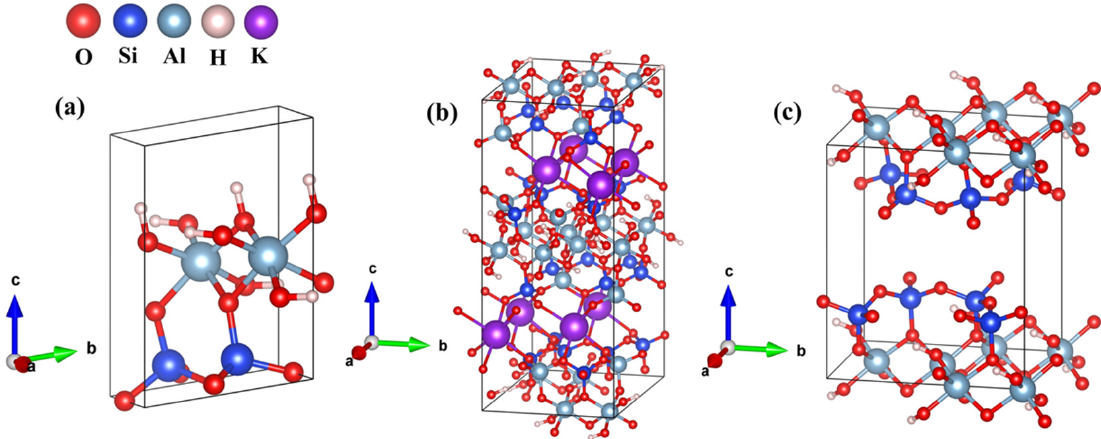
Figure 1. Shows ball-and-stick figures using Vesta [18] for ( a ) kaolinite, ( b ) muscovite, and ( c ) montmorillonite. The color